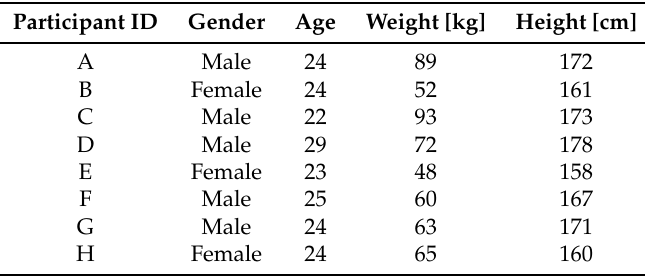
Table 2. Information of 8 participants.